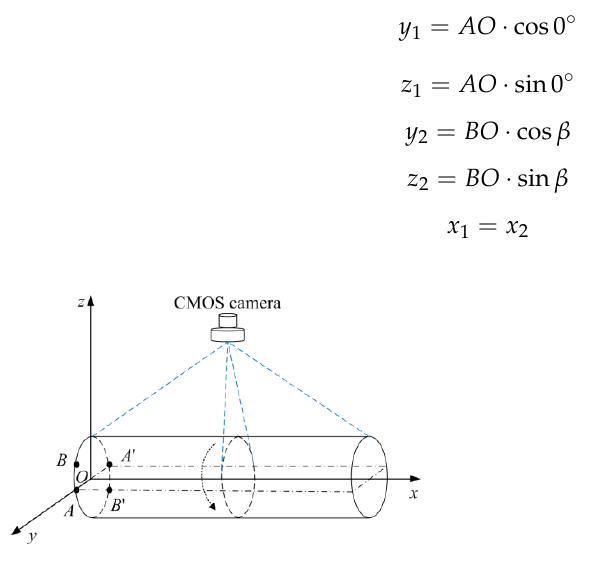
Figure 7. Position relation of camera and workpiece in the measuring coordinate.